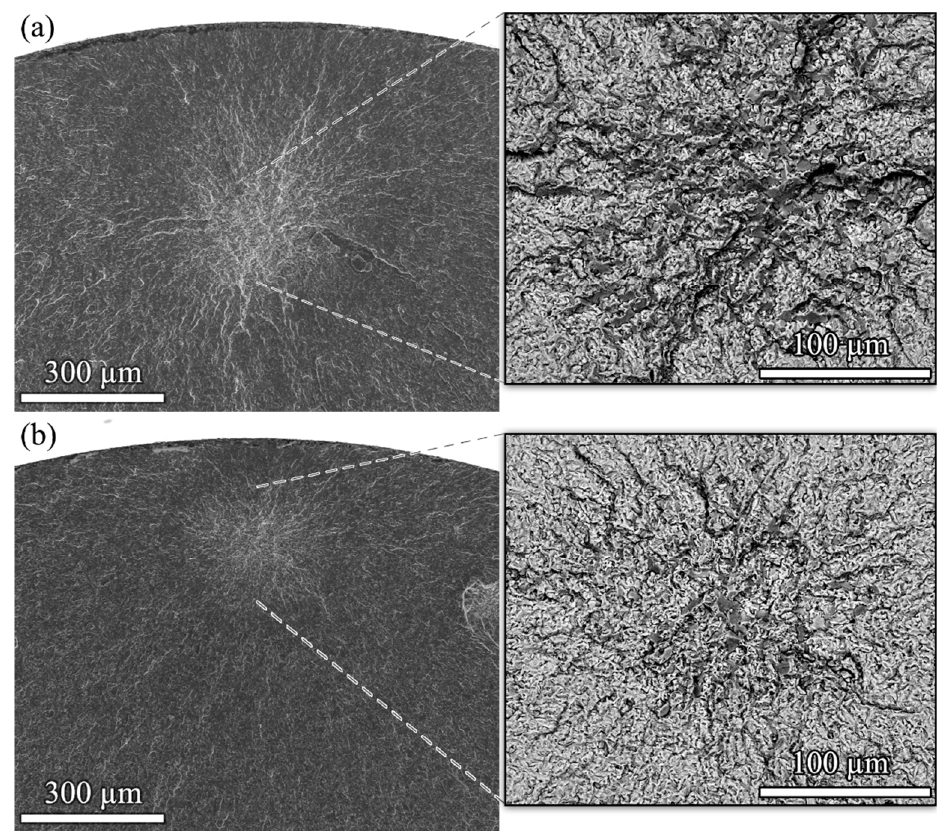
Figure 13. Fracture surfaces from specimens that were cycled at σ a = 350 MPa; at ( a ) 20 kHz, N f = 1.18 × 10 7 and at ( b ) 55 Hz, N f = 1.51 × 10 7 .